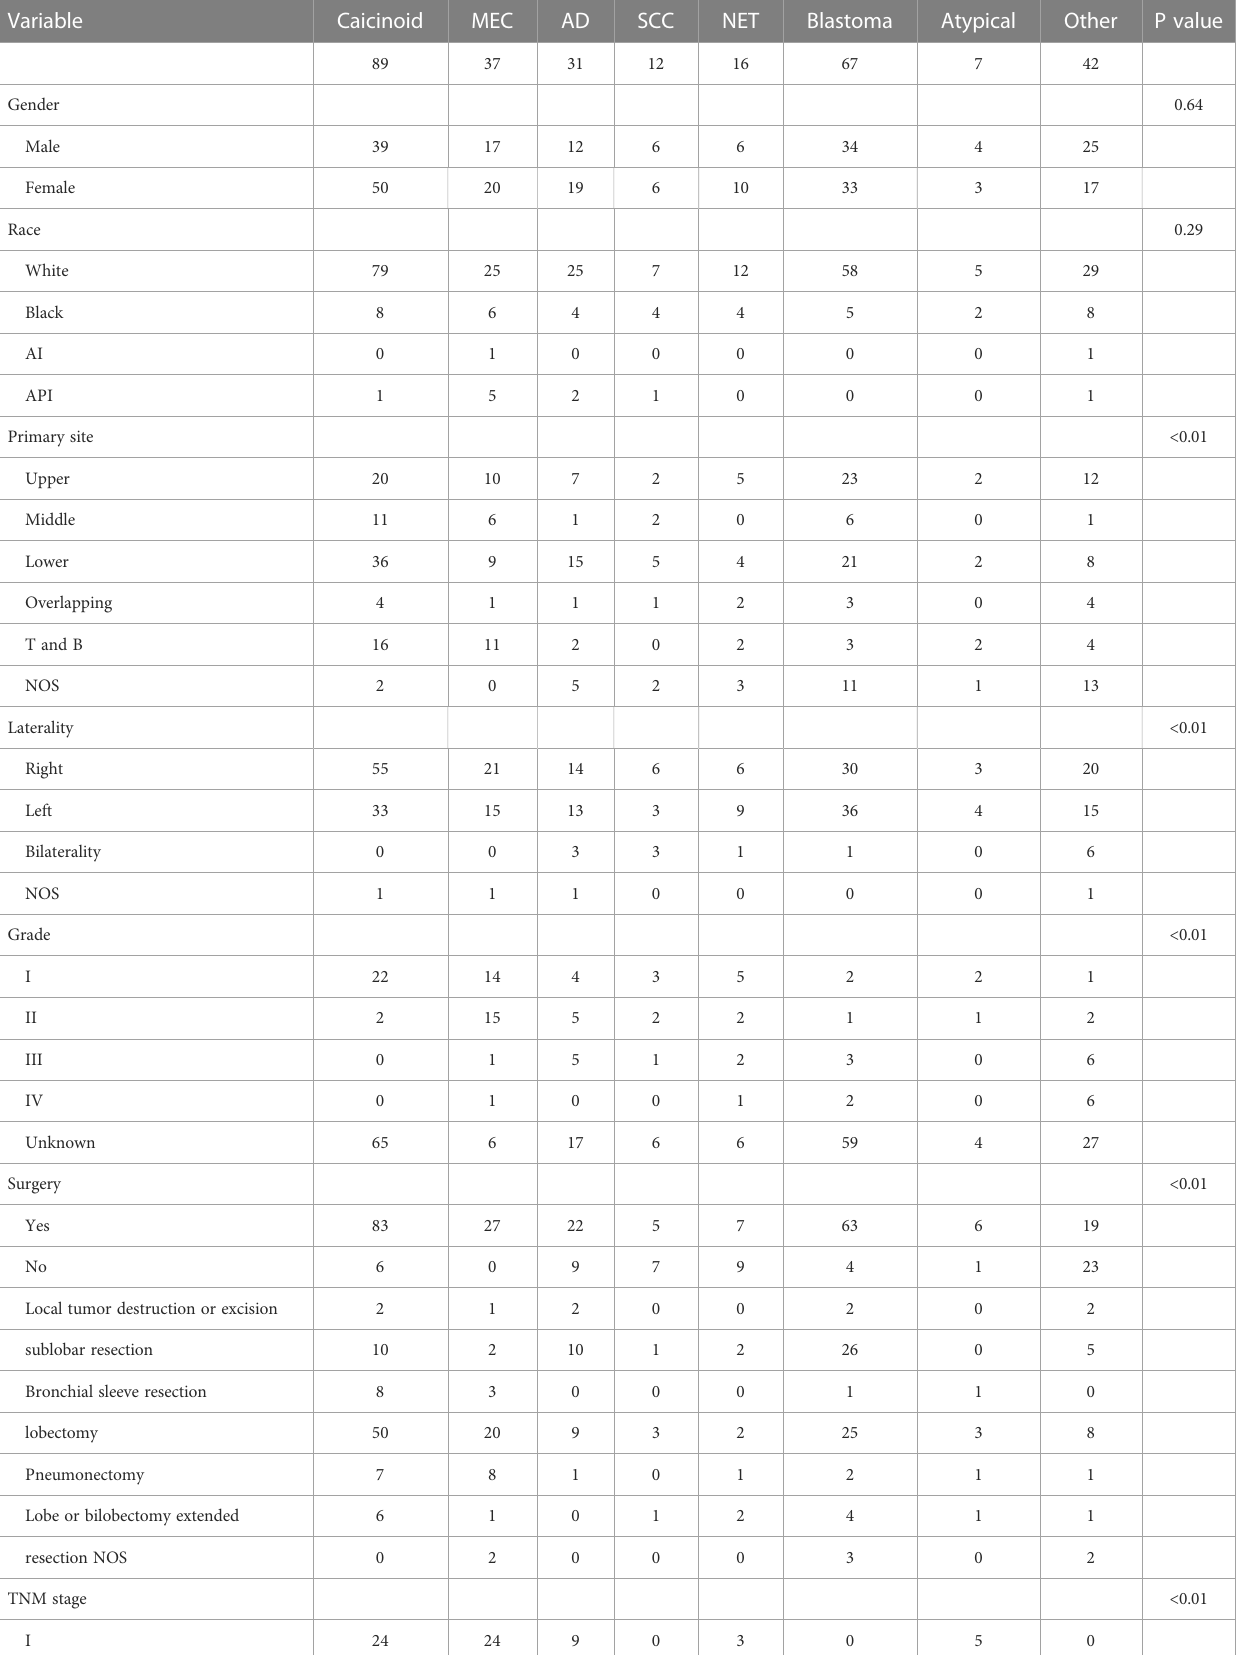
TABLE 3 Demographics and Clinical Characteristics by histopathologic tumor